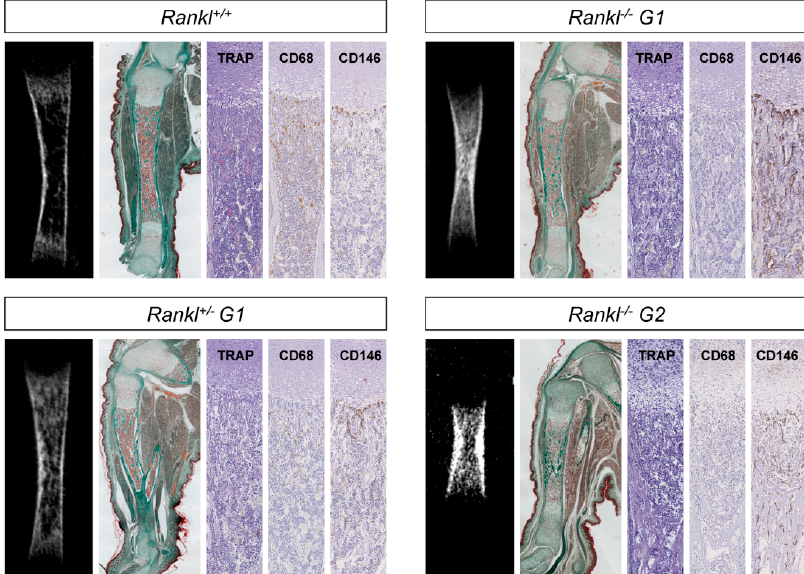
Figure 4. MicroCT (mCT) and histological comparative analysis of the appendicular skeleton of first- and second-generation Rankl null mutant mice. Tibias were chosen as representative bone of the appendicular skeleton. Second-generation null mutants revealed significantly delayed tibia development in comparison with first-generation null mutants, as shown by mCT and Masson trichrome staining. Interestingly, comparing the mCT and histological sections of wild type and heterozygous pups revealed a pre-osteopetrotic phenotype in the heterozygous pup. TRAP staining was observed in wild type and heterozygous pups, with a lower number of stained cells in the heterozygous pups. CD68 immunostaining decreased gradually (in intensity and number of stained-cells) from the wild type to the first-generation null mutant pups. No TRAP expression was observed in the second-generation null mutants, while small, round CD68 cells were visible in the subchondral area. CD146 immunostaining increased gradually (in terms of intensity and number of stained cells) from wild type to first-generation null mutant pups, while it was comparable in first- and second-generation null mutant pups. Masson trichrome magnification 10 × ; TRAP, CD68, and CD146 magnification 40 × . Numbers of pups: 4 +/+, 8 G1+/ − , 5 G1 − / − , and 5 G2 − / − .